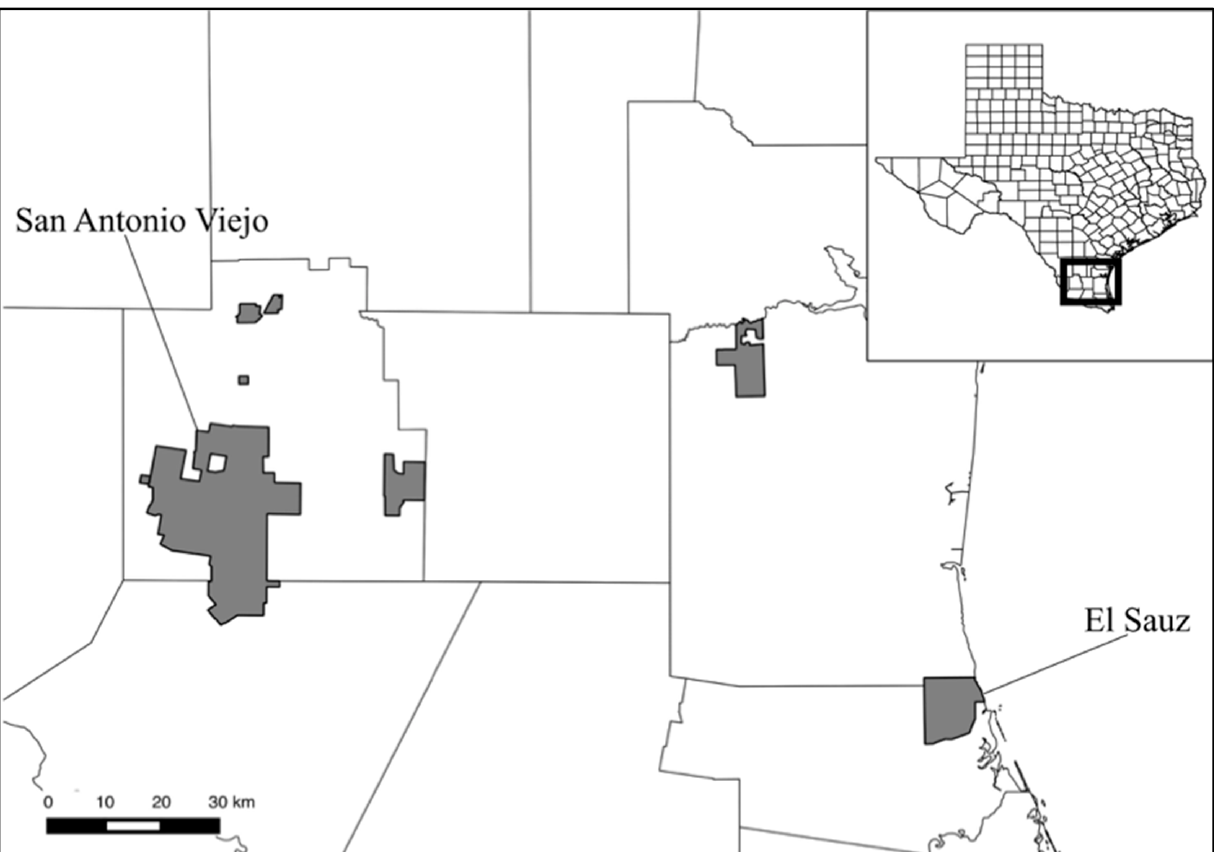
Figure 1. Map of Texas showing locations of East Foundation Properties. El Sauz and San Antonio Viejo ranches were utilized in this study from 2013 to 2015. For further reference, the El Sauz headquarters is located at 26.537 latitude, − 97.448 longitude. The San Antonio Viejo headquarters is located at 26.955 latitude, − 98.834 longitude.